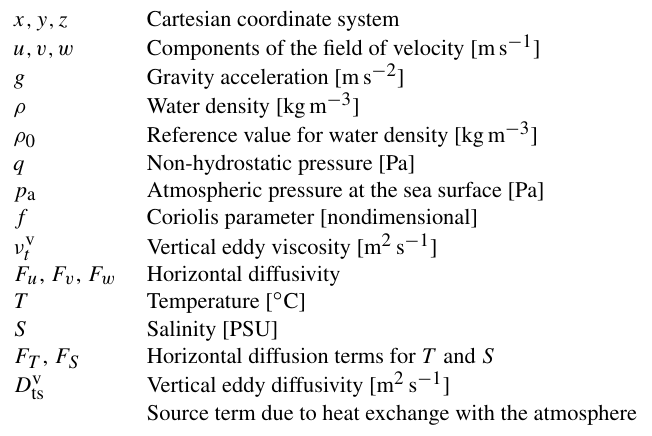
Table A1. Symbols used in the governing Eq.